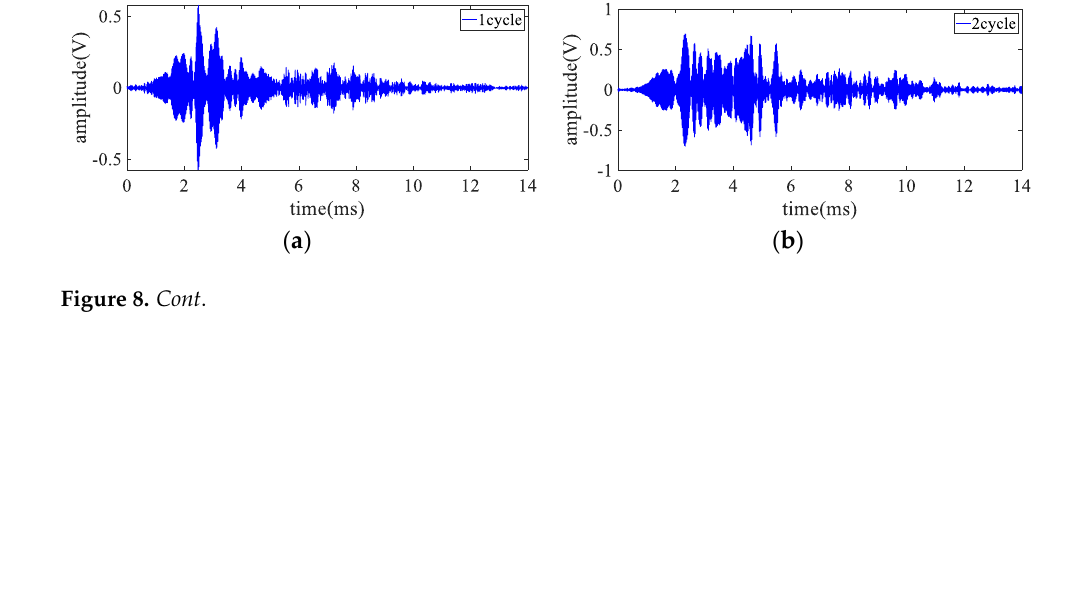
Figure 7. Results analysis of encoding excitation by 15 − bit Kasami sequence under different carrier cycles, ( a – d ) the corresponding received signals, ( e – h ) the decoding results.